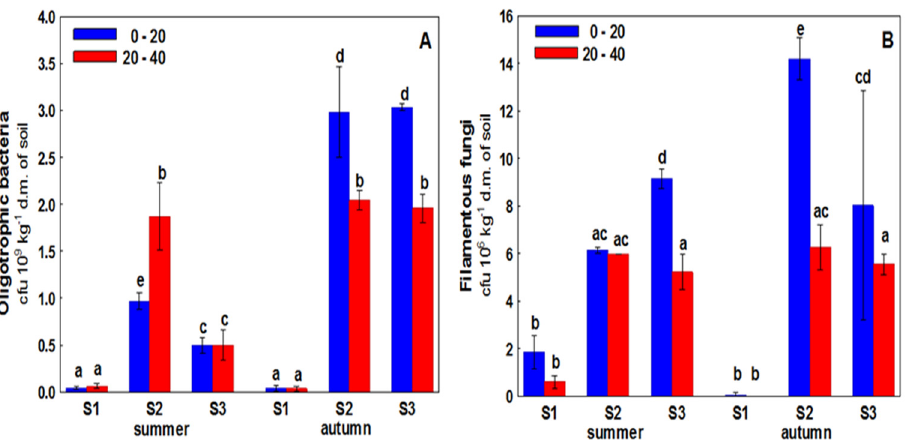
Figure 1. Number of selected groups of bacteria and fungi in soil from 0–20 and 20–40 cm depths: ( A ) oligotrophic bacteria; ( B ) filamentous fungi. Legend: S1, S2, S3—sampling sites located S1—5.88 m, S2—22.7 and S3—50.08 m from the reservoir with liquid post-production waste. Vertical lines indicate the standard deviation. Different letters above the columns indicate significant differences at p < 0.05.